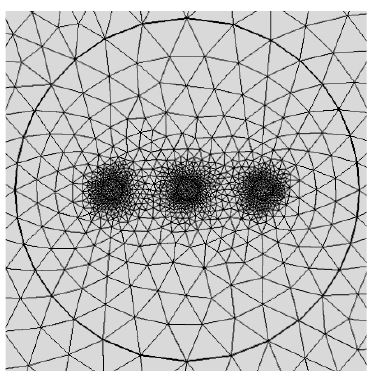
Fig. 2 Finite element